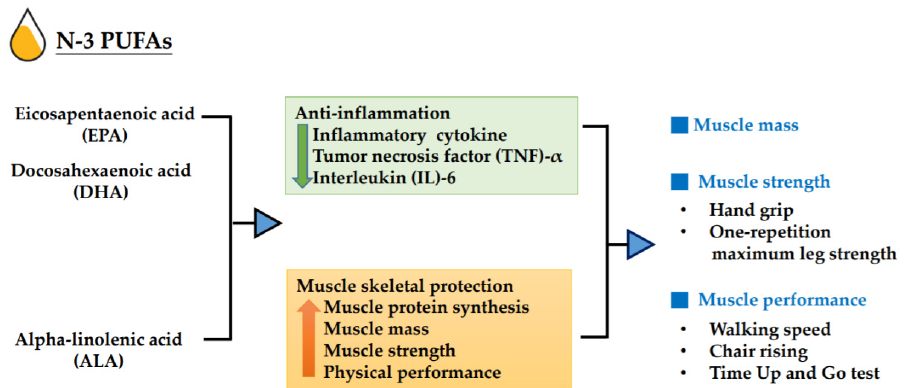
Figure 1. Impact of n-3 polyunsaturated fatty acids (n-3 PUFAs) on muscle mass, muscle strength, and muscle performance.